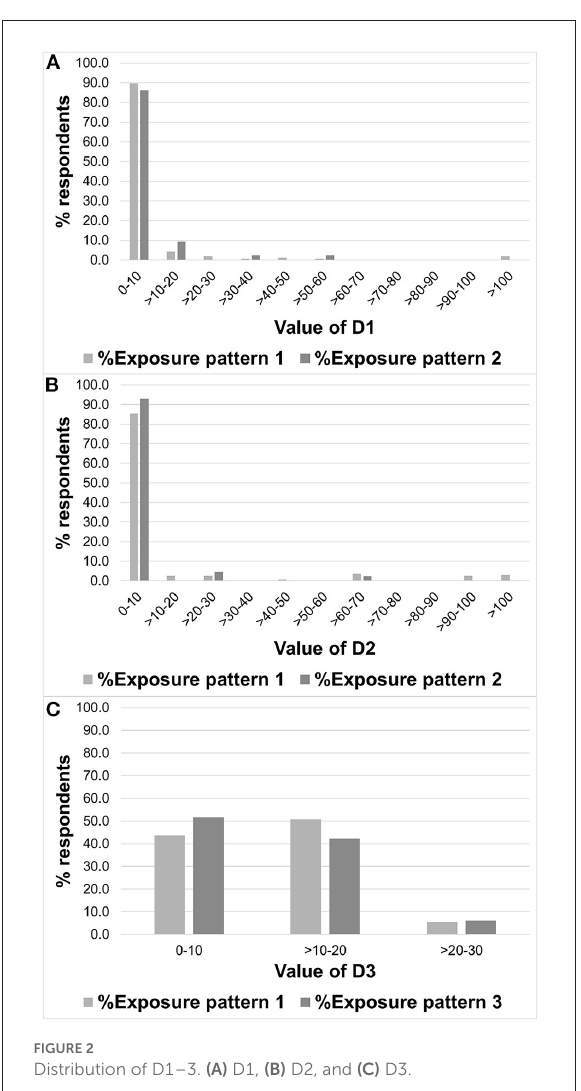
FIGURE2 Distribution of D1–3. (A) D1, (B) D2, and (C) D3.